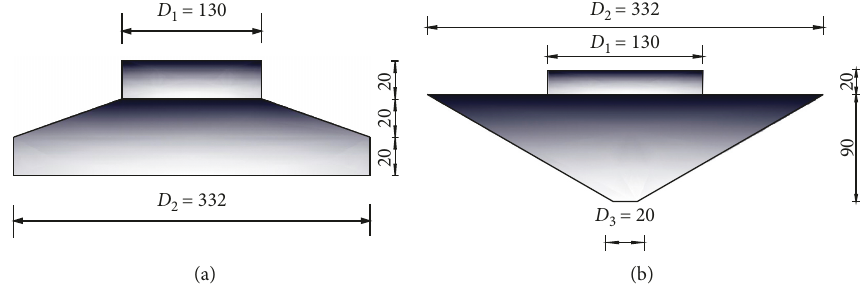
Figure 3: Dimension of the scale foundation model. (a) Circular foundation. (b) Cone-shaped foundation. Unit: mm.